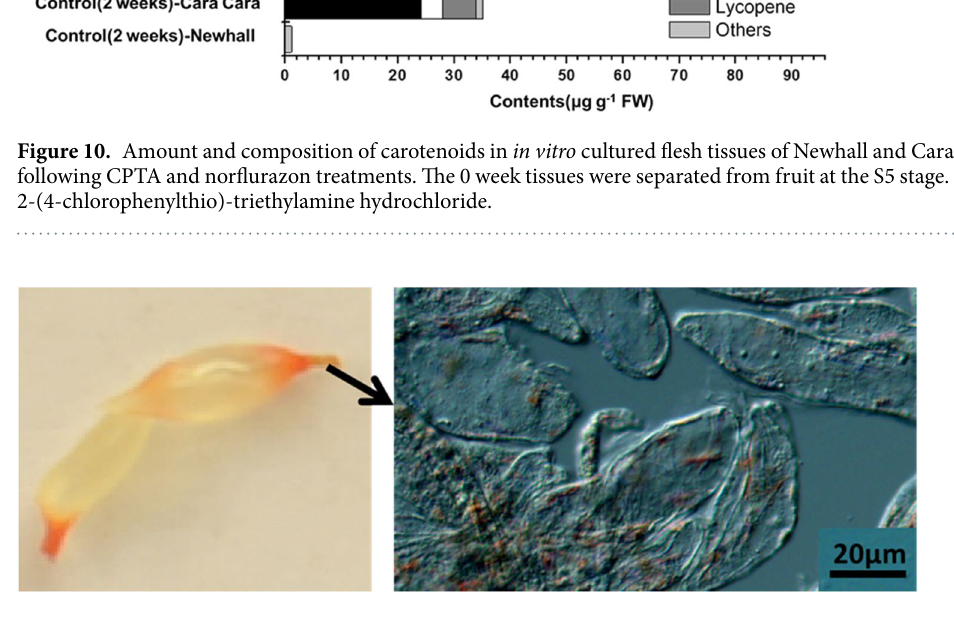
11 Scientific RepoRts | 7: 761 | DOI:10.1038/s41598-017-00898-y